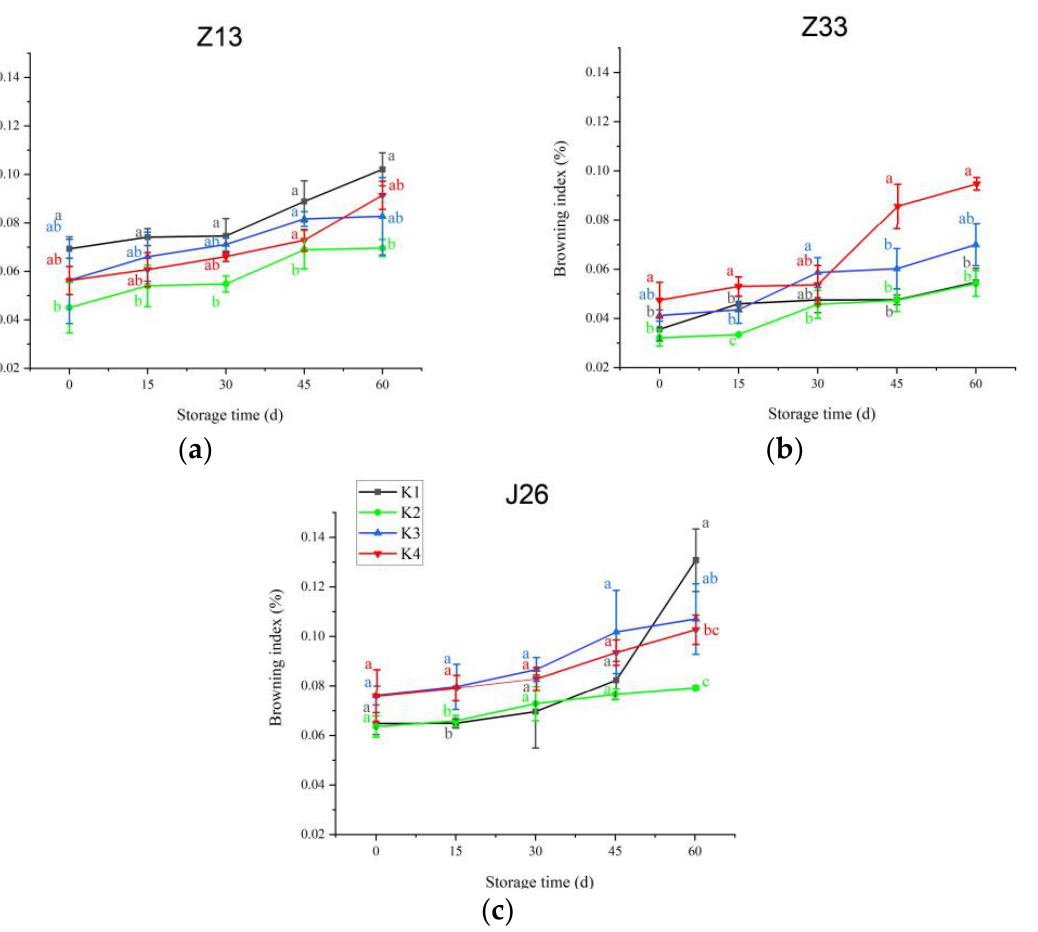
Figure 6. Browning index of the tuberous root of different UCZ treatments during storage. ( a ) Browning index of Z13; ( b ) browning index of Z33; ( c ) browning index of J26. Values within the same storage day of the same year followed by the same letter are not significantly different at the 5% level according to ANOVA-Duncan’s multiple range test. K1: Normal basal fertilizing without UCZ; K2: Normal basal fertilizing with UCZ; K3: Rich basal fertilizing without UCZ; K4: Rich basal fertilizing with UCZ.